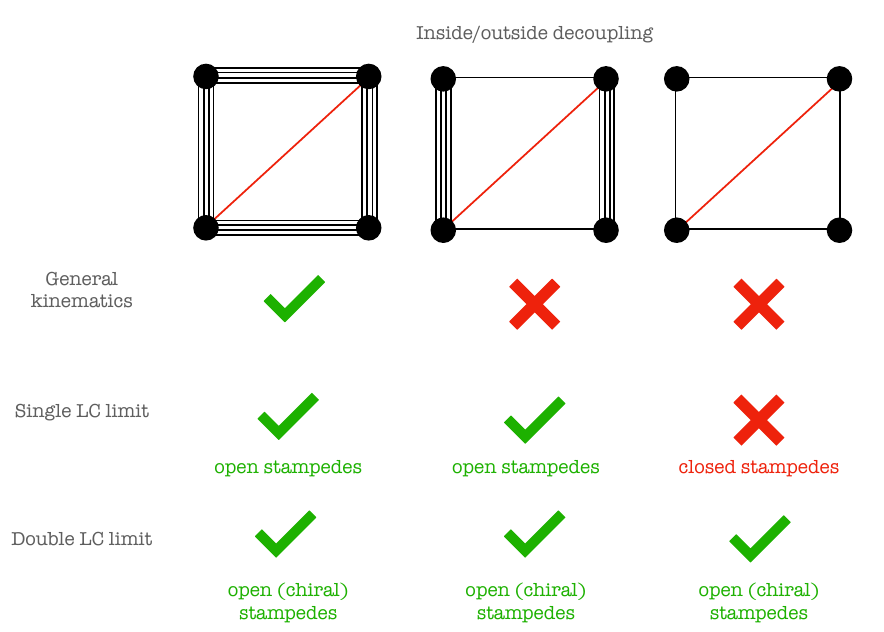
Figure 9 . Summary of decoupling conditions. In the first line we show square skeleton diagrams for different thickness of the edges. We distinguish the condition of factorization into octagons by the symbol X , while not factorizable cases are marked by × . As long as we take at least a single double scaling null limit (i.e. for the last two lines of the figure) we can predict the outcome through the stampedes even when there is no decoupling as summarized in the